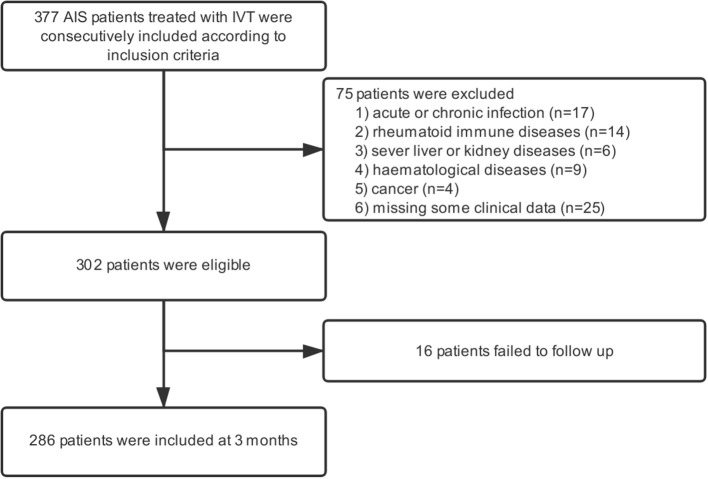
Study flow chart. AIS, acute ischaemic stroke; IVT, intravenous thrombolysis.